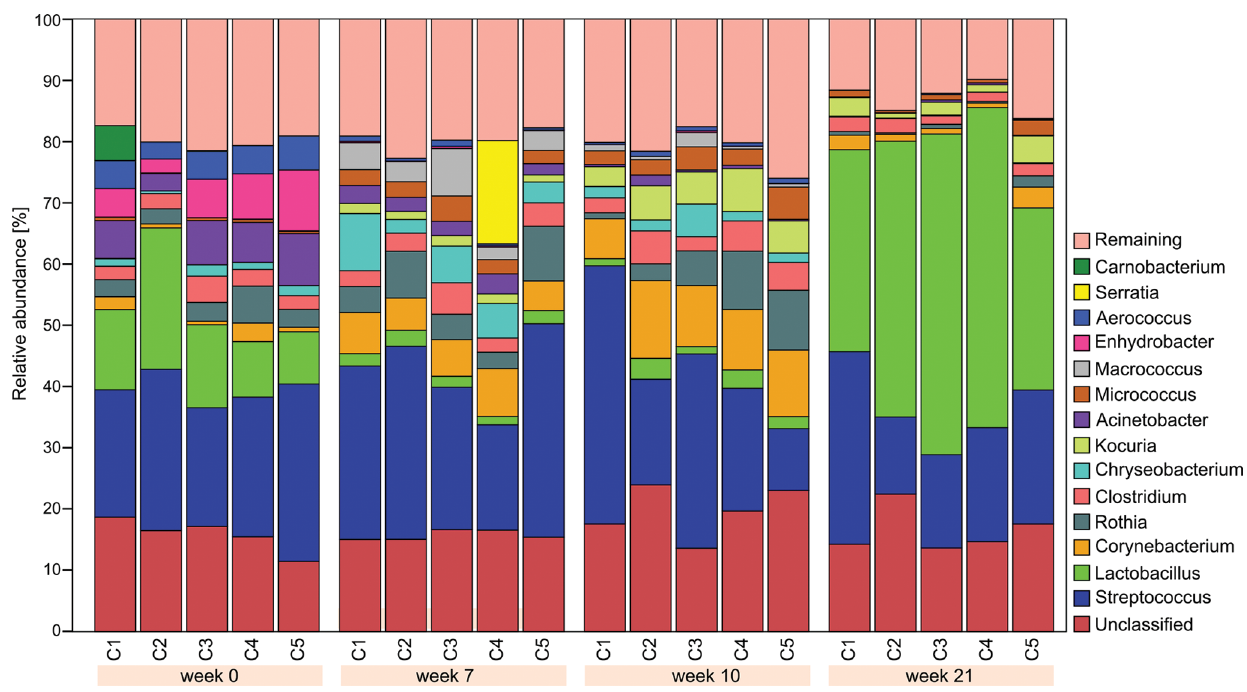
Figure 1. Relative abundance of the most predominant bacterial genera in the pinna of porcine ears at various time points in the absence of mites. At week 0, Streptococcus was the most dominant genus, followed by Lactobacillus, Actinectobacter, Enhydrobacter, Aerococcus and Rothia in decreasing abundance. At week 7, Streptococcus was still the most dominant genus, followed by smaller abundance of Corynebacterium, Chryseobacterium, Rothia, Clostridium and Lactobacillus . Similarly at week 10, Streptococcus was the dominant genus, followed by Corynebacterium, Rothia, Kocouria, Clostridium and Lactobacillus . At week 21, Lactobacillus was the most dominant, followed by Streptococcus and Kocuria . Only genera, with a relative abundance of $ 10% in at least one sample are